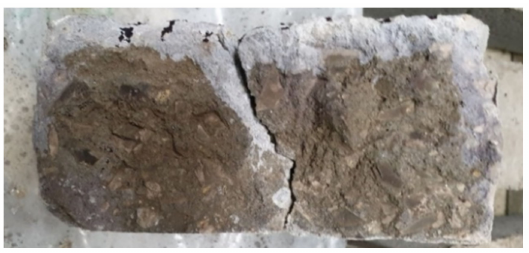
Figure 6. Naturally cracked specimens subjected to chloride attack, after splitting and pulverizing with silver